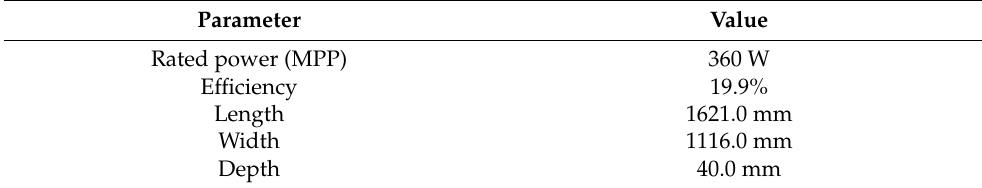
Table 1. Performance specifications of one PV panel.